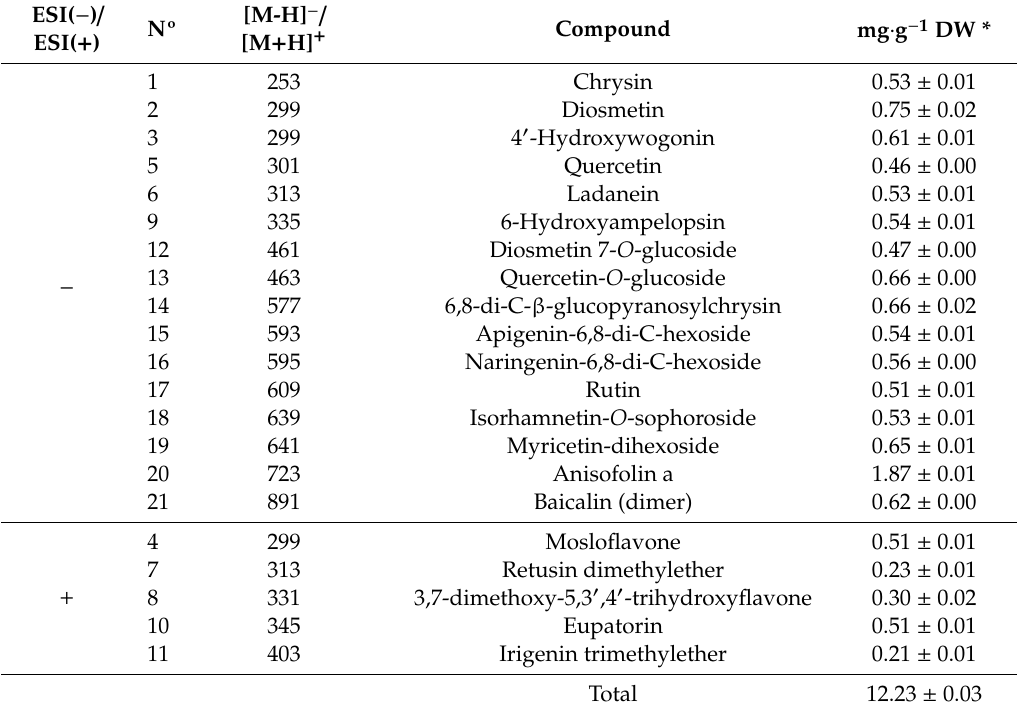
* Values are expressed as mean of results from three analyses ±